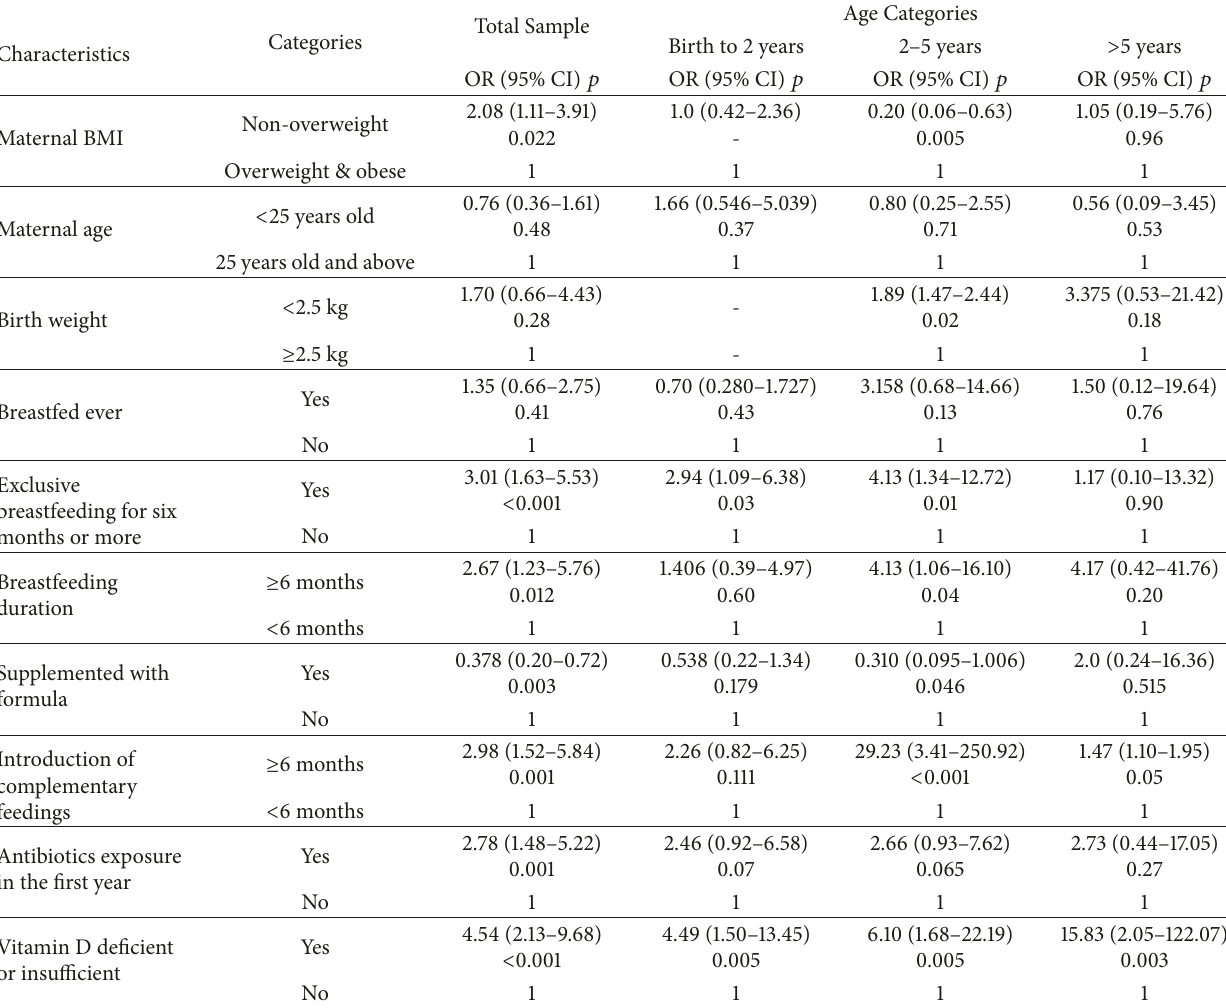
Table 4: Unadjusted odds ratios using univariate logistic regression for FA allergy status as the dependent variable and early feeding practices and exposures as independent variables.